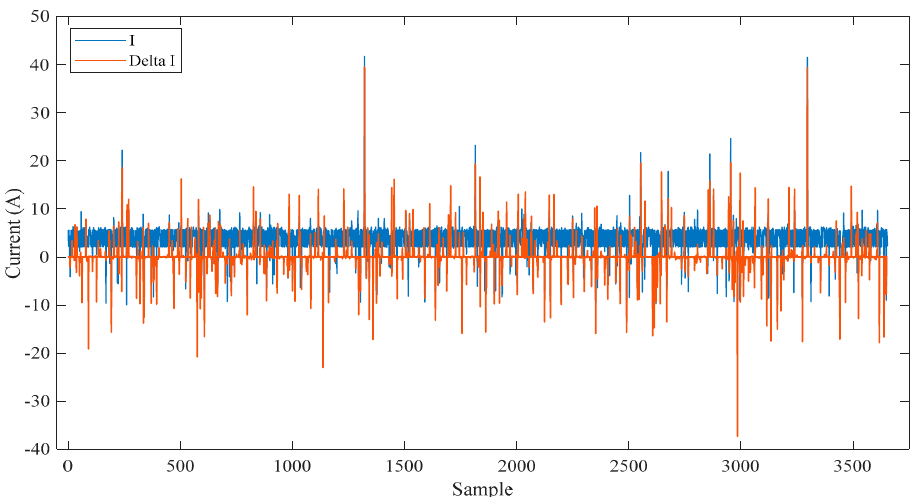
Figure 5. The input testing data of the decision tree.